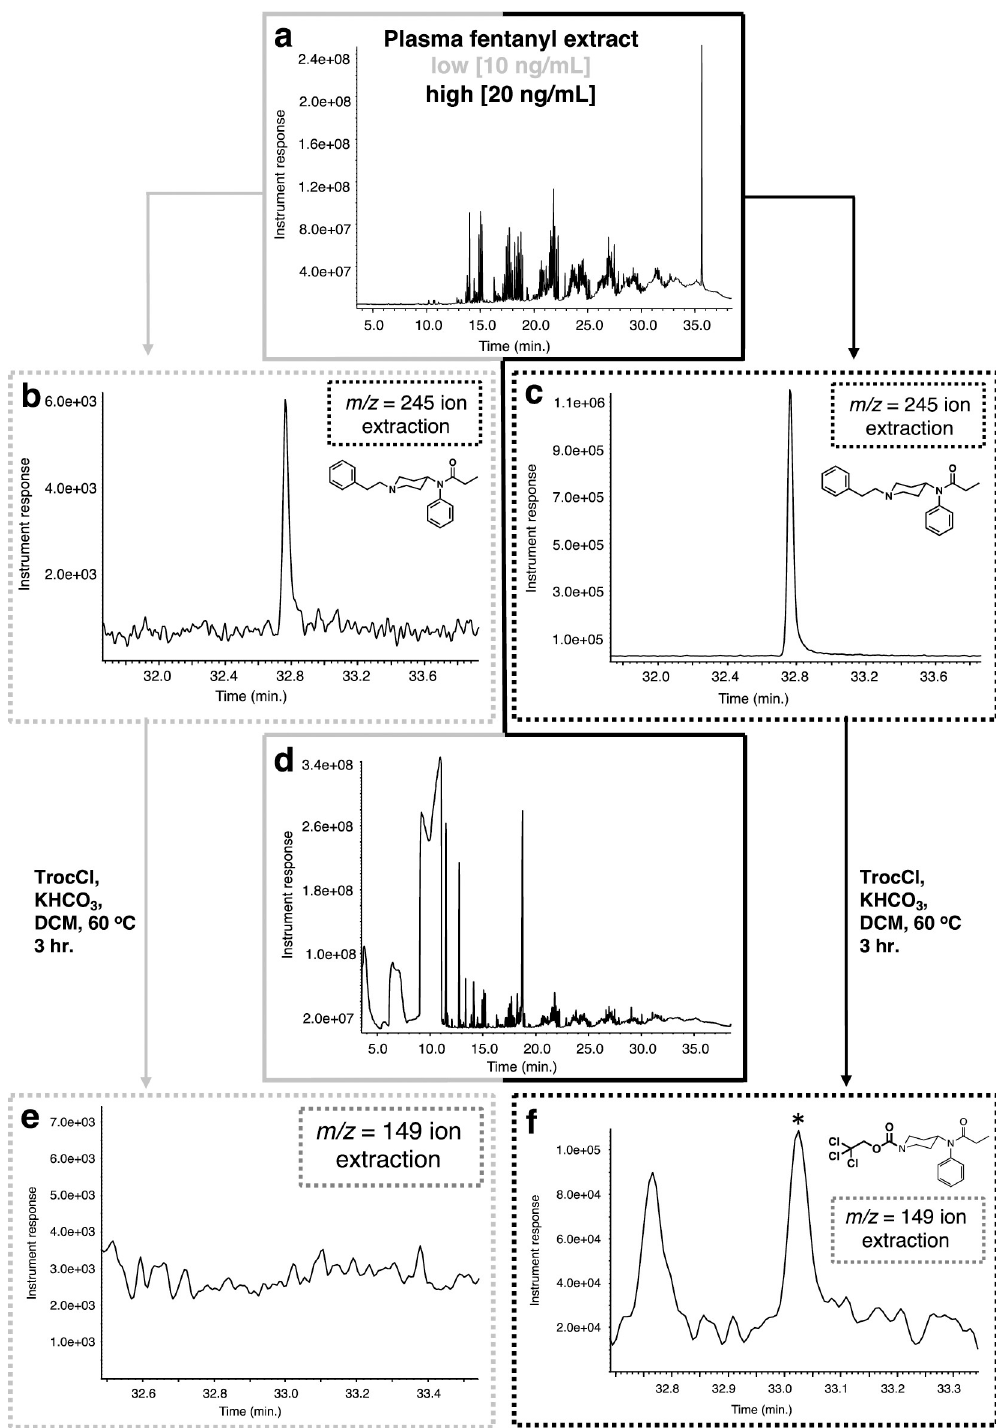
Fig 3. Extraction and reaction of fentanyl with Troc-Cl when spiked in plasma at two concentrations (10 and 20 ng/mL). (a) GC chromatogram of extracted plasma sample; (b) extracted ion (m/z = 245) chromatogram for fentanyl (rt = 32.8 min.) for low concentration spike; (c) extracted ion (m/z = 245) chromatogram for fentanyl for high concentration spike; (d) GC chromatogram of the reaction between extracted plasma sample and Troc-Cl; (e) extracted ion (m/z = 149) chromatogram for Troc-norfentanyl for the low concentration sample showing no discernible peak while (f) extracted ion (m/z = 149) chromatogram for Troc-norfentanyl for the high concentration sample shows a clear peak (rt = 33.03 min.) composed of